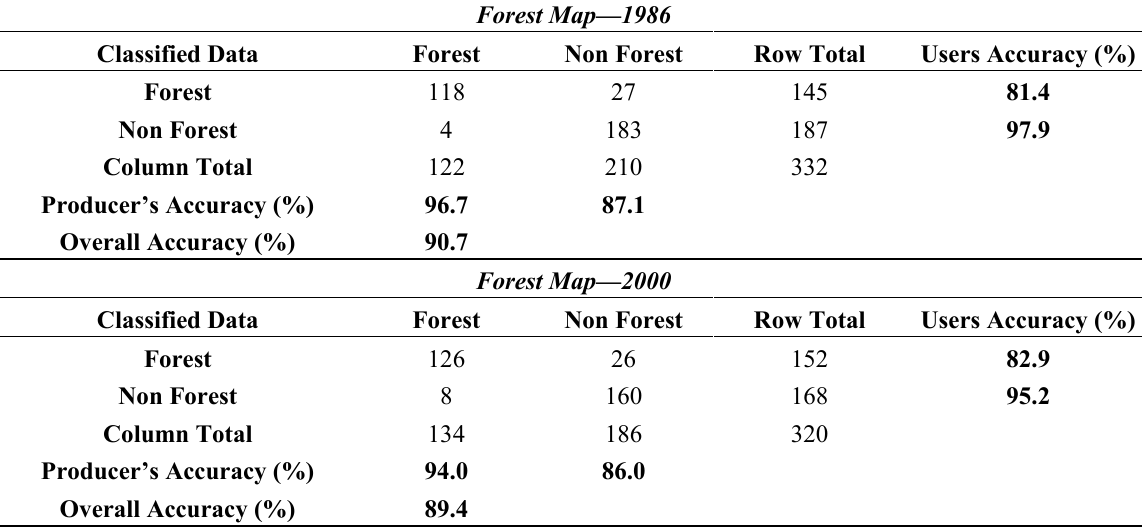
Table 3. Error matrix of 1986, 2000 and 2014 classified forest maps for Delta